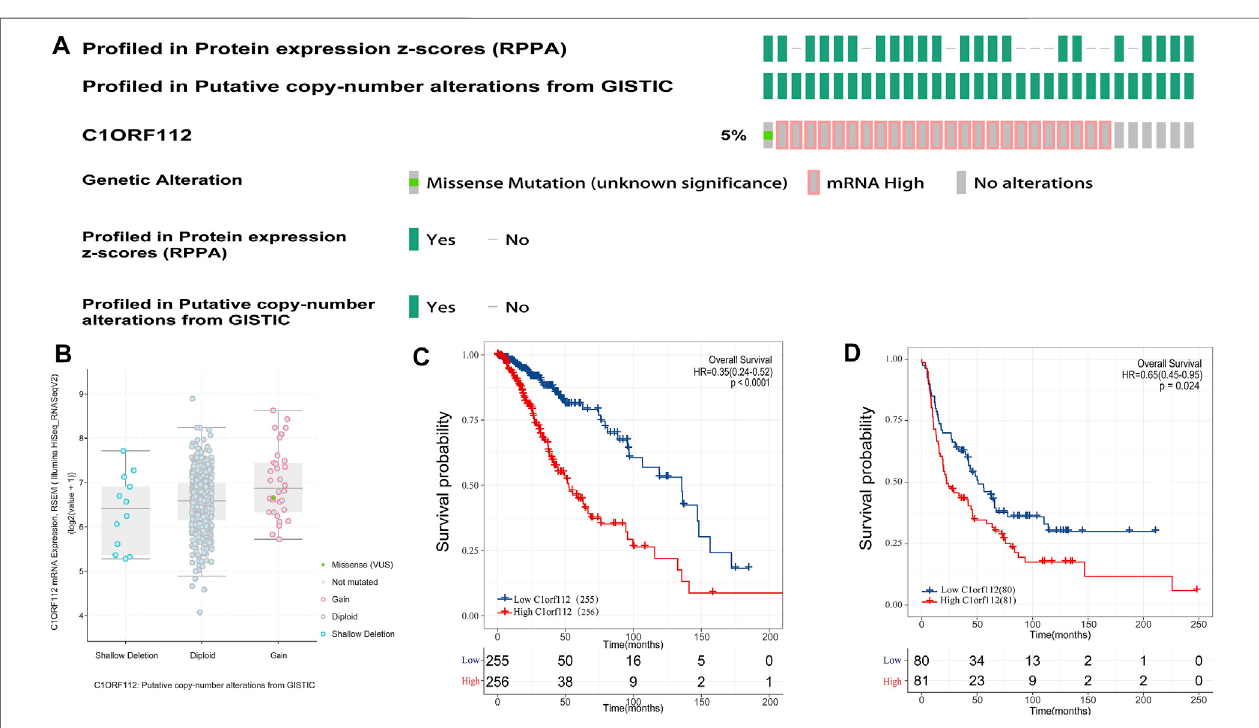
Frontiers in Genetics |